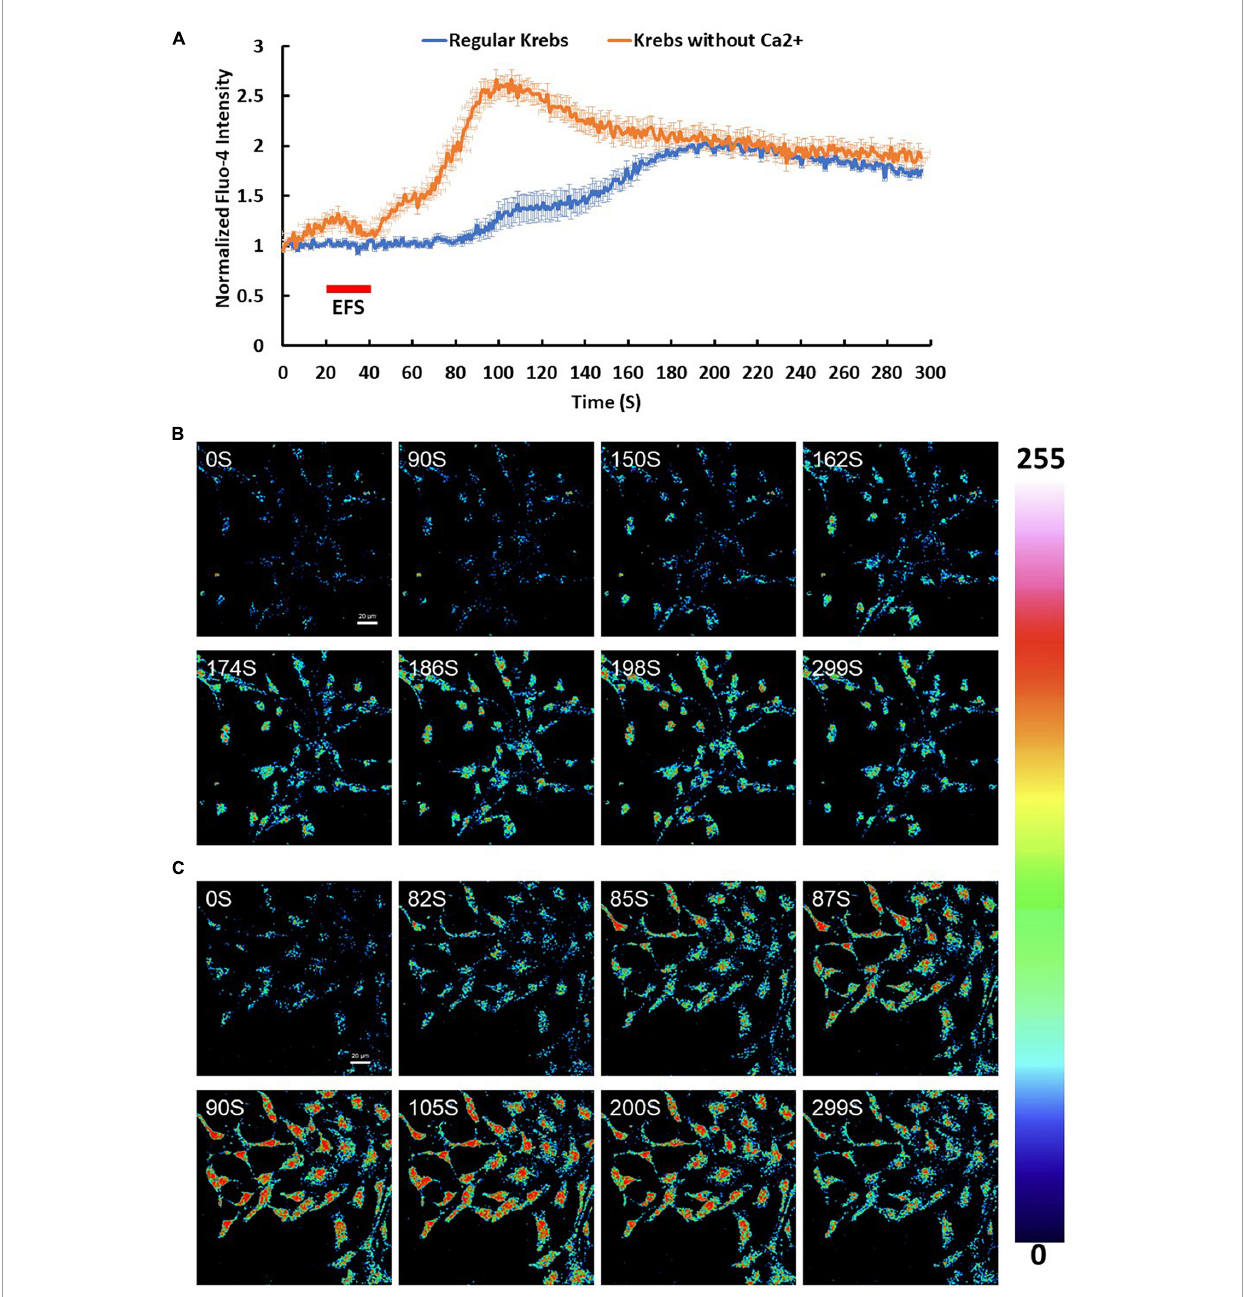
FIGURE3 Calcium (Ca 2 + ) changes in response to EFS. (A) The graph shows average intensity changes of Ca 2 + indicator Fluo-4 AM in response to EFS in regular Krebs buffer (blue) and in Krebs buffer depleted from Ca 2 + (red). The EFS was applied at second 20 of the experiment for a duration of 20 s. Experiments were conducted in three independent brain preparations, each with three technical repeats. Data shown in (A) represents the average of three independent experiments and is expressed as normalized fluorescence intensity ratio relative to the averaged three images obtained prior to the addition of stimulus. (B,C) Sequential confocal images of Fluo-4 AM labeled cortical cells at the indicated time intervals corresponding to before, during and after exposure to EFS with intensity of 7.69 V/cm (B) in regular Krebs buffer and (C) in Krebs depleted from Ca 2 + . Scale bar = 20 µ m. Intensity changes in (B,C) are color-coded whereby high levels are red and low levels are blue. EFS, electric field